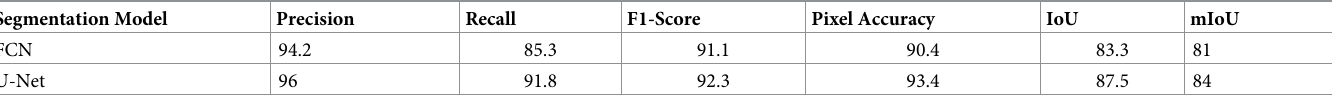
Table 2. Comparative analysis of FCN and U-Net